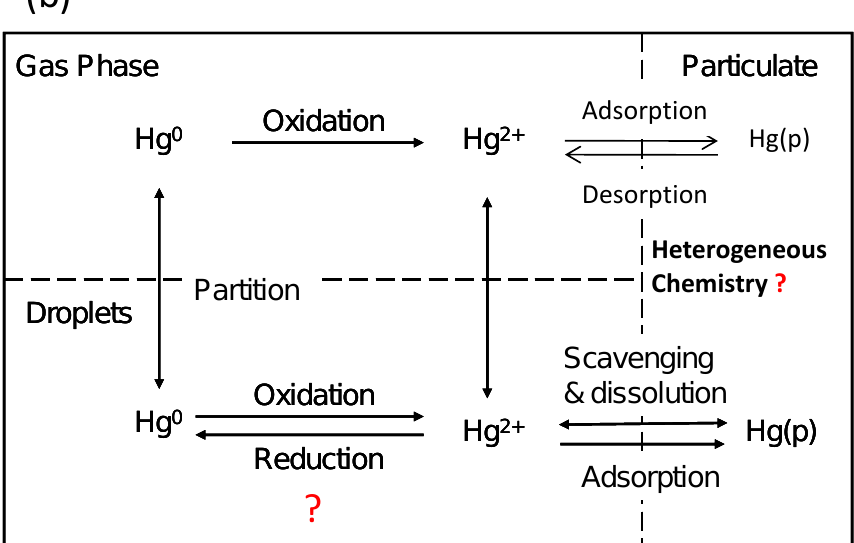
Figure 1. ( a ) Mercury transformations in the environment; ( b ) Atmospheric chemistry of mercury. Adapted and modified from [3]. The question mark (?) indicates some major knowledge gaps in Hg cycling in the environment.